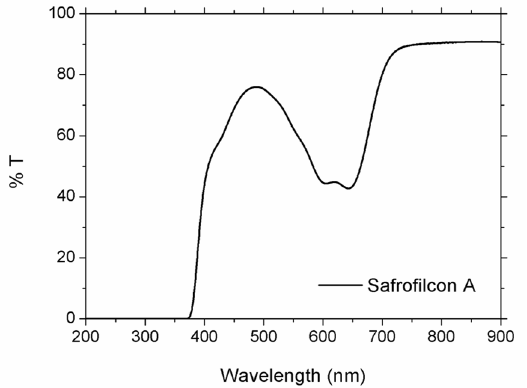
Figure 2. Optical transmission spectra of Safrofilcon-A hydrogel polymer.